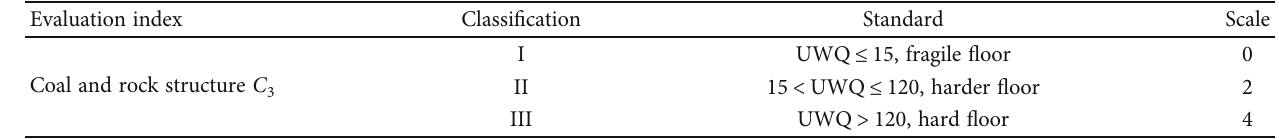
Table 6: Structural classi fi cation of coal and rock.